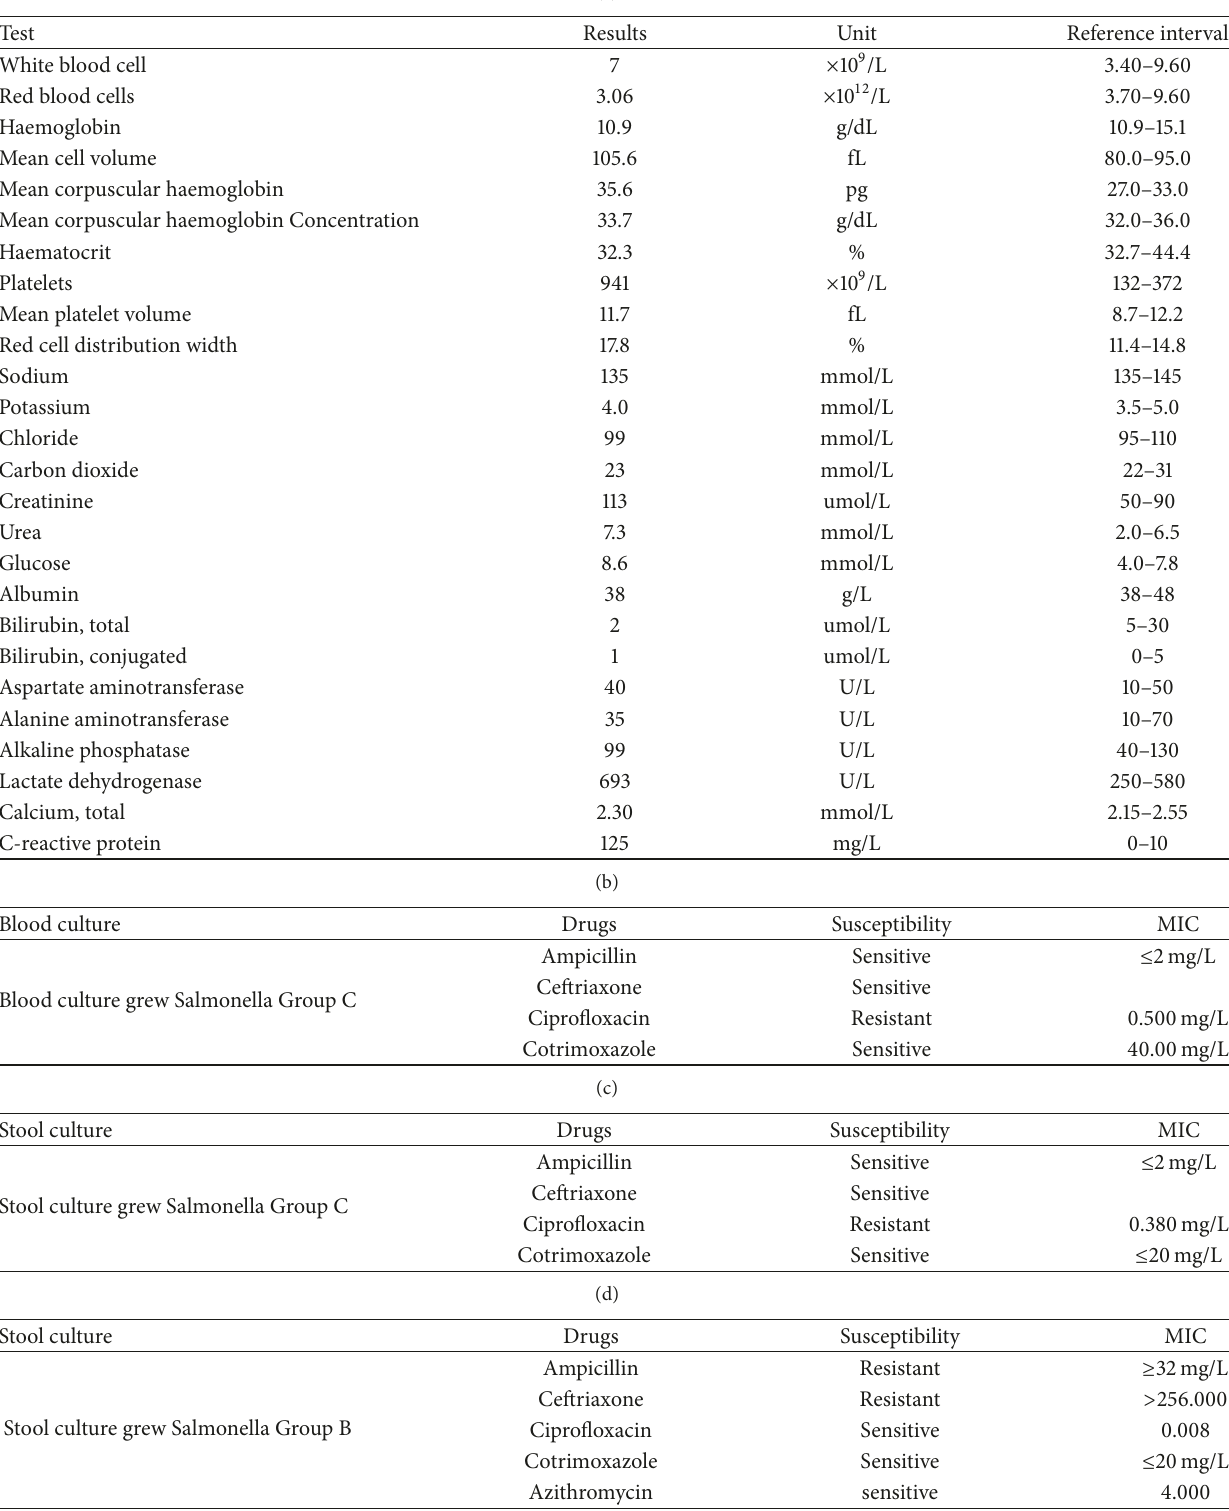
Table 1: Initial blood test